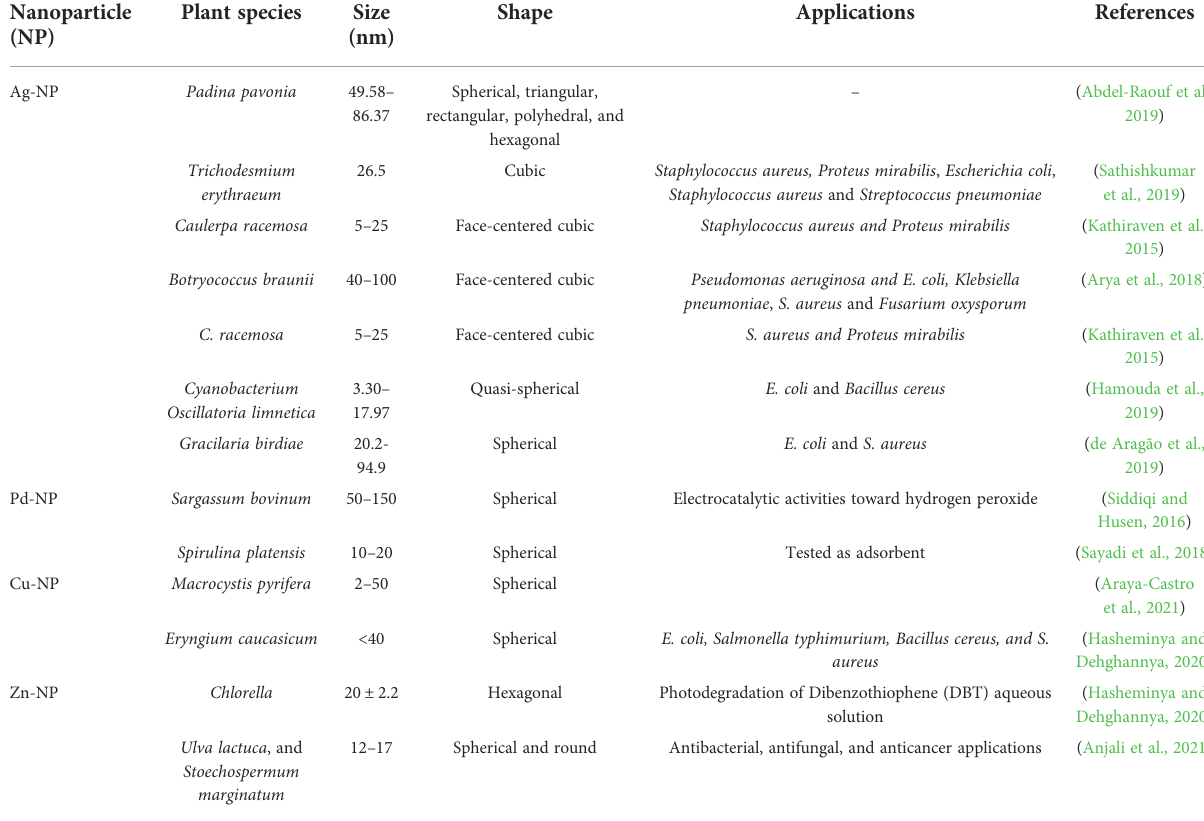
TABLE 2 Examples of synthesis of engineered nanomaterials using algae/bacteria/yeast. Nanoparticle